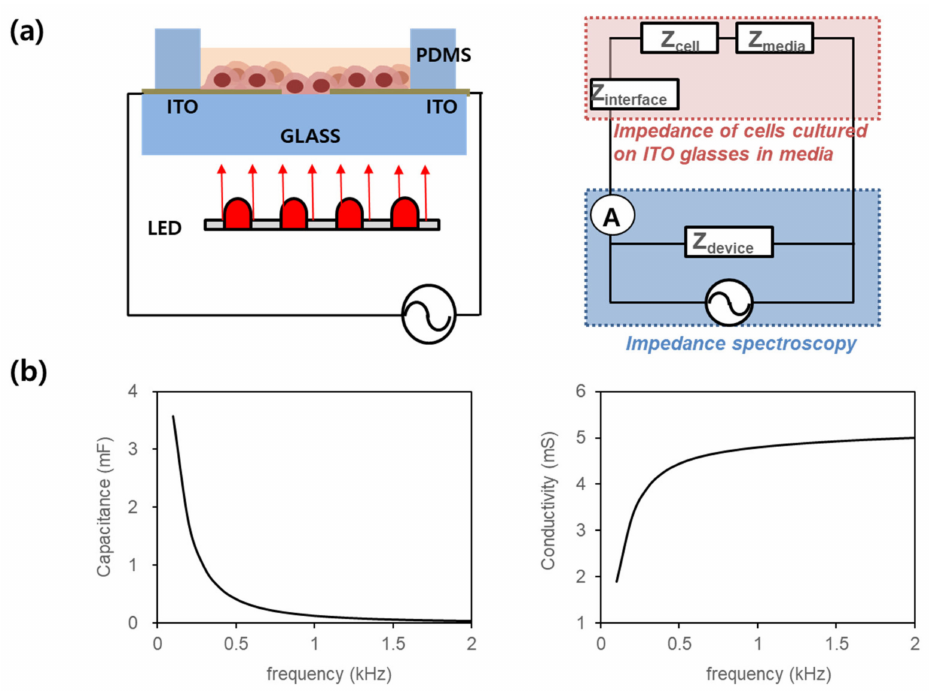
Figure A1. ( a ) An equivalent circuit diagram to measure the impedance of cells cultured on ITO glasses in culture media. ( b ) Capacitance and conductance spectroscopies according to